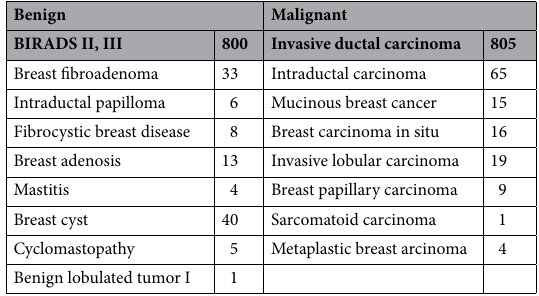
Table 1. Pathological types of collected cases.